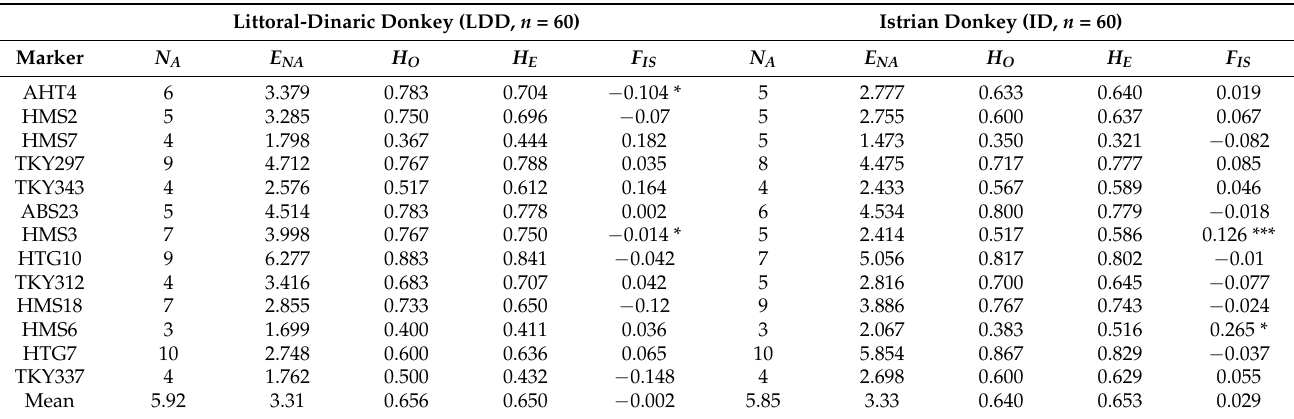
Table 4. Indices of genetic diversity in Istrian donkey and Littoral-Dinaric donkey breeds in Croatia. Abbreviations in Table 3 are identical to those in this